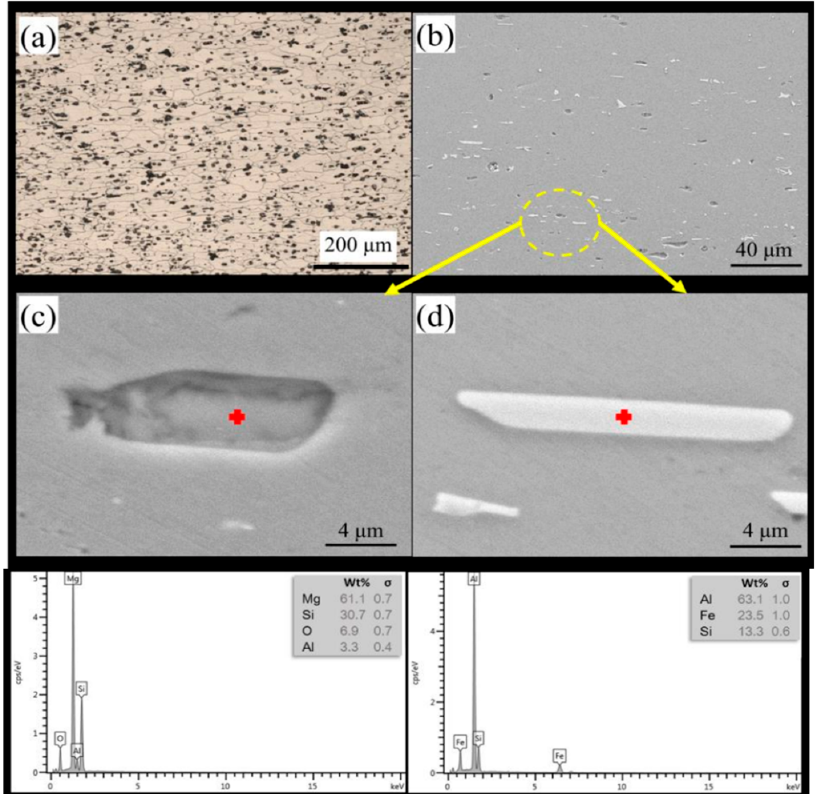
Figure 3. Microstructure of Al6061(T6)-BM: ( a ) optical image, ( b ) FE-SEM image, and ( c , d ) energy dispersive X-ray spectroscopy (EDX) point